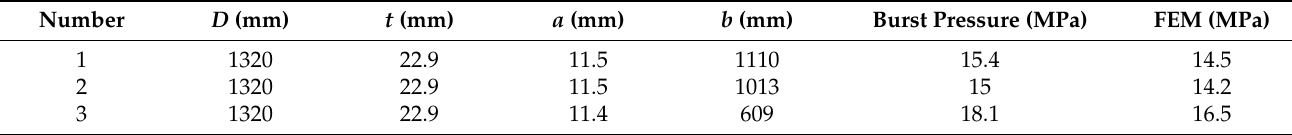
Table 2. Geometric parameters and FEM failure pressure of the X100 pipeline.